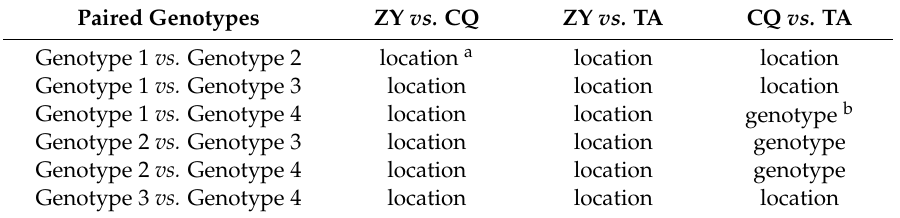
Table 3. The predominant factor for the variation of chemical compositions obtained from paired locations and genotypes (ZY, Zhuyang; CQ, Changqing; TA, Taian. This table was a summary of Figure